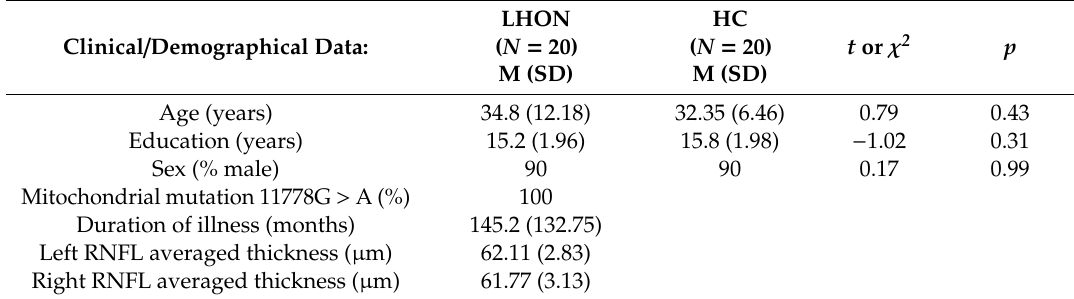
Table 1. The demographical and clinical values for both selected groups.